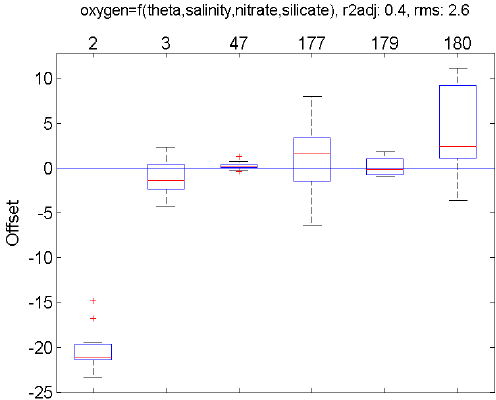
Figure 9. MLR results for O 2 in the Nansen Basin (o ff sets in µ molkg − 1